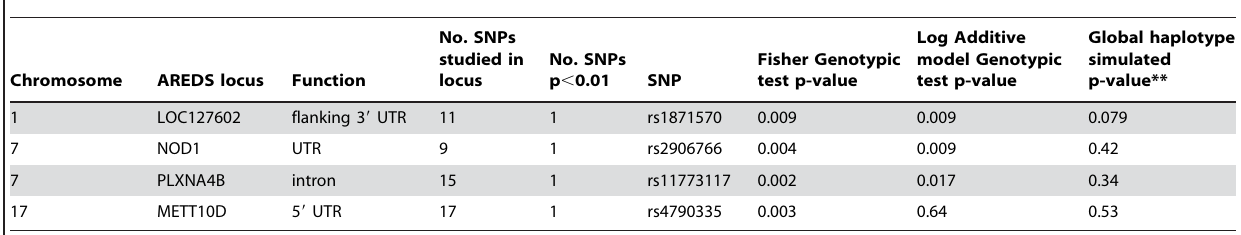
Table 3. Attempted replication of AREDS loci using 225 Tag-SNPs and 18 nsSNPs genotyped on the Mayo subjects.